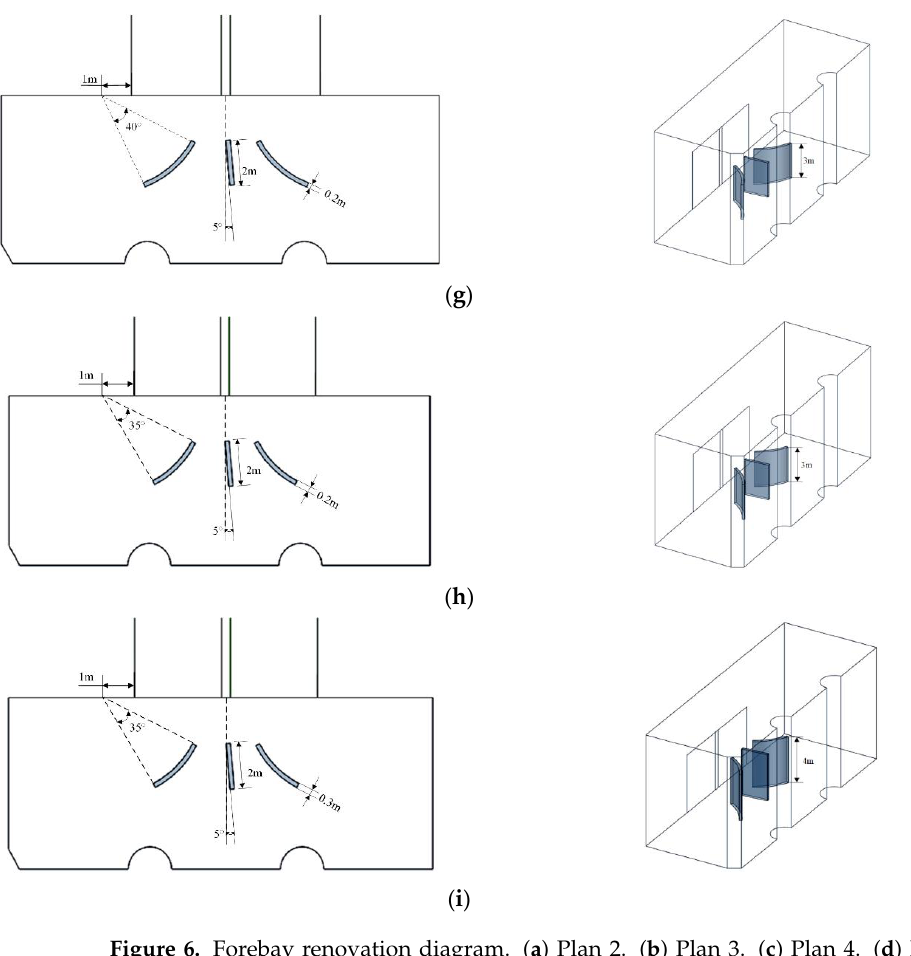
Figure 6. Forebay renovation diagram. ( a ). Plan 2. ( b ). Plan 3. ( c ). Plan 4. ( d ). Plan 5. ( e ). Plan 6. ( f ). Plan 7. ( g ). Plan 8. ( h ). Plan 9. ( i ). Plan 10.